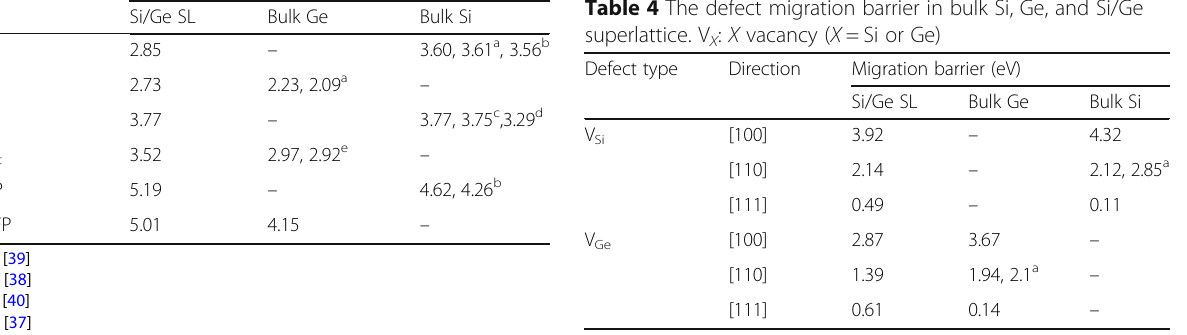
Table 3 The defect formation energies in bulk Si, Ge, and Si/Ge superlattice. V X : X vacancy ( X = Si or Ge); X int : X interstitial ( X = Si or Ge); FP defect: Frenkel pair defect Defect type